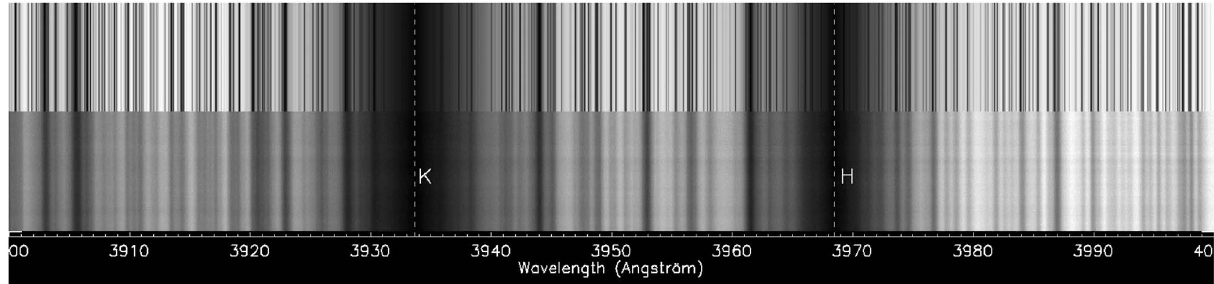
Fig. 6. Spectrum ( k , x ) between 3900 and 4000 Å displaying CaII K and H lines near disk center. Top: high resolution atlas ( R = 2 (cid:3) 10 6 , Delbouille et al., 1973). Bottom: Spectroheliograph ( R =